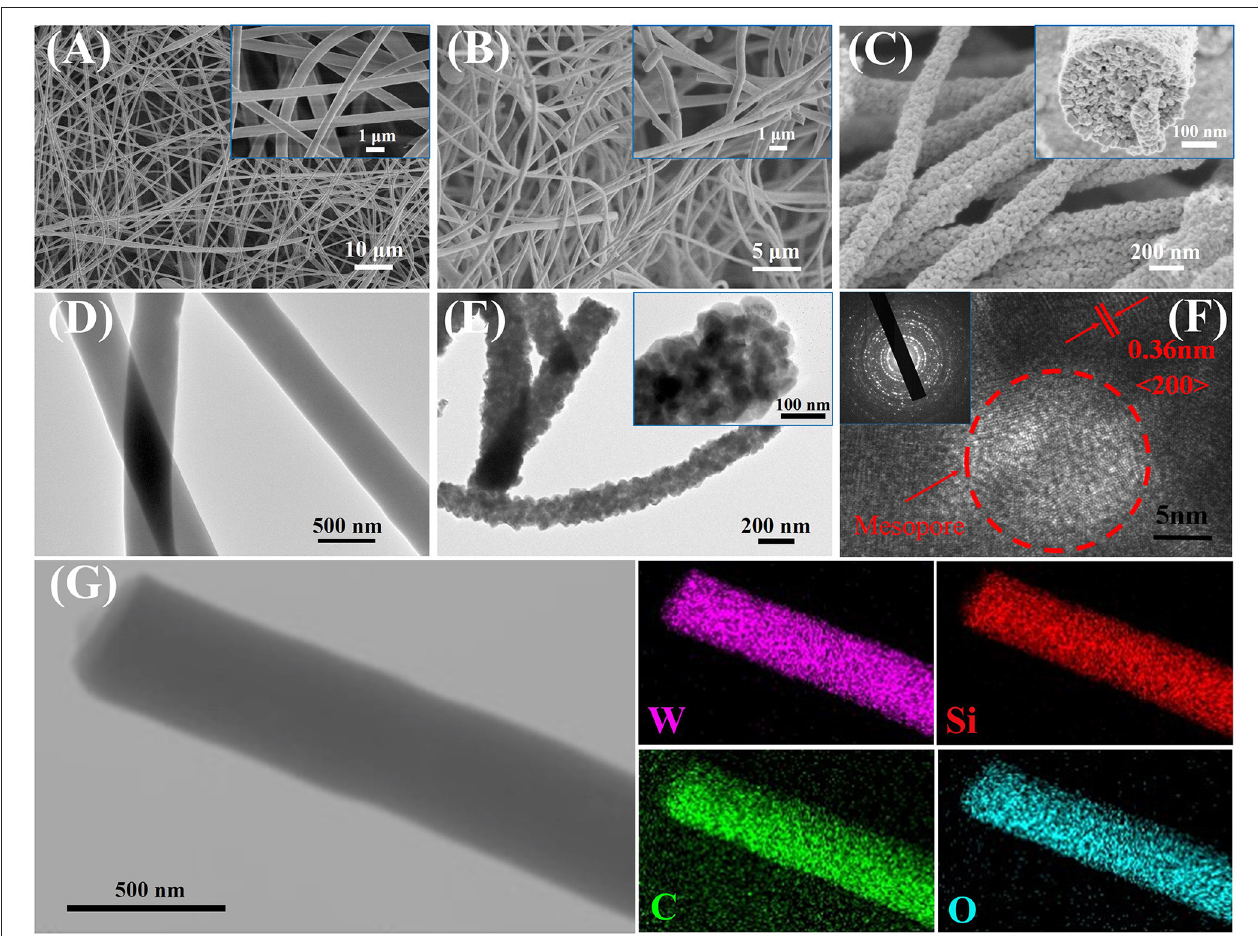
FIGURE 2 | FESEM images of (A) as-spun tungsten species/PVP/SiO 2 (25nm) NFs, (B) WO 3 /carbon/SiO 2 (25nm) NFs, (C) mesoporous WO 3 -25 NFs. TEM images of (D) WO 3 /carbon/SiO 2 (25nm) NFs, (E) mesoporous WO 3 -25 NFs. HRTEM image of (E) mesoporous WO 3 -25 NFs. (F) Scanning TEM image and the corresponding EDS mapping images (G) of elemental W, Si, C, and O for WO 3 /carbon/SiO 2 (25nm)